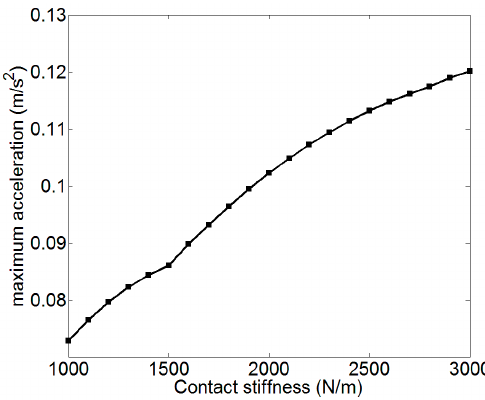
Figure 10. The influence of the contact stiffness.